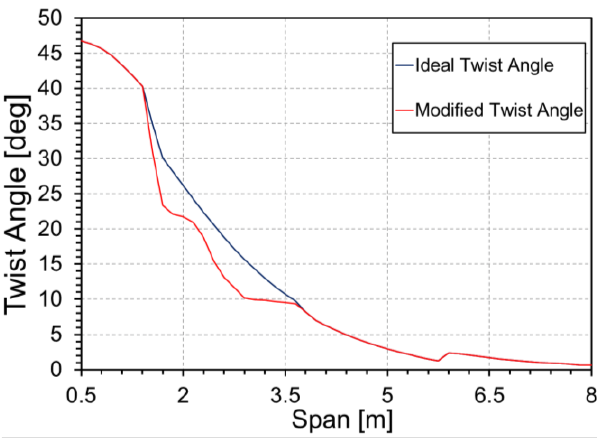
Figure 4. Changes to the optimal twist distribution to ensure good stall regulation.